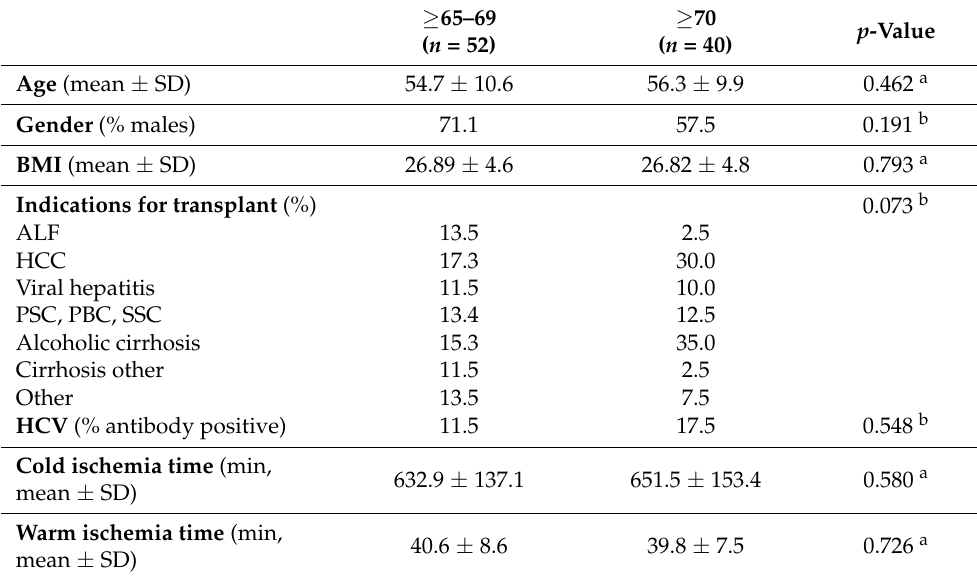
Table 2. Recipient